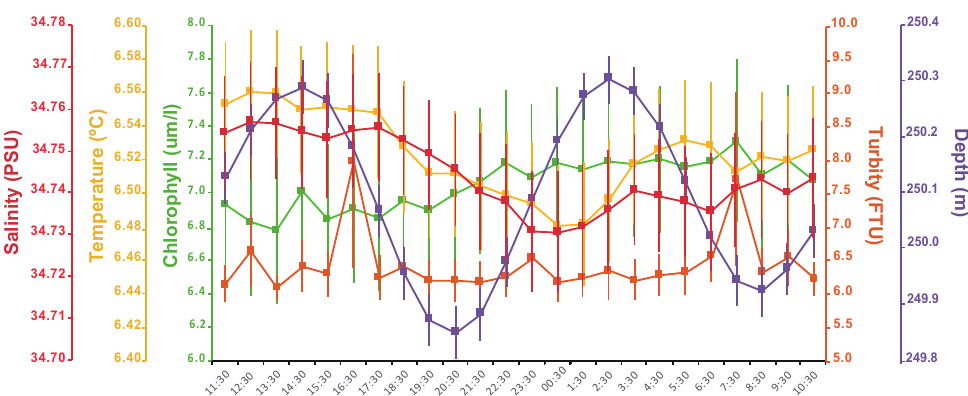
Figure 11. Waveform analysis outputs of oceanographic data, where all hourly averaged values are presented with their standard deviation.